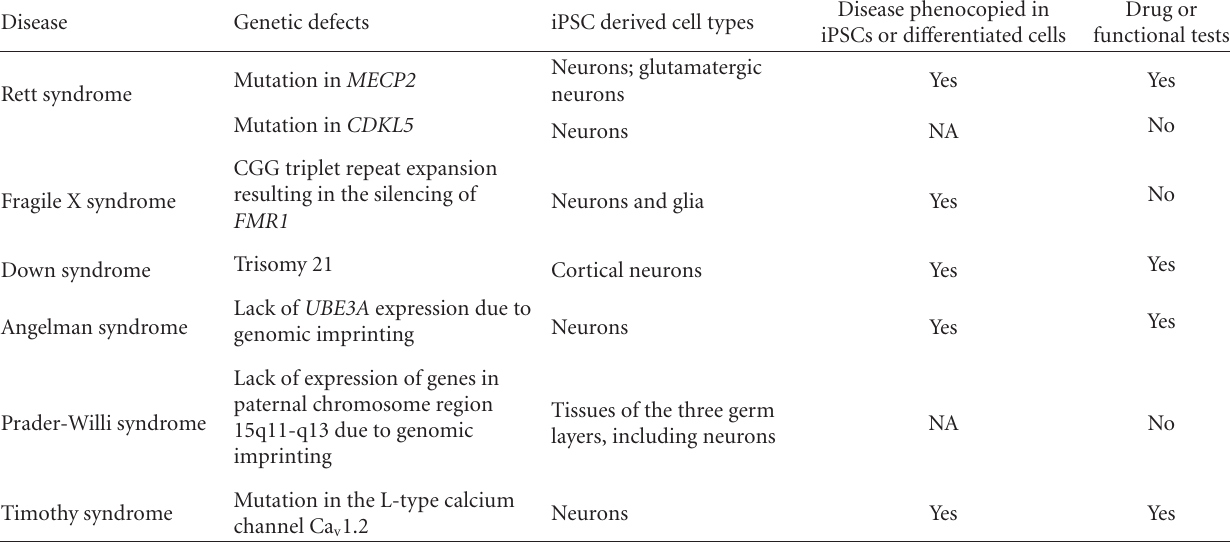
Table 1: Genetic neurodevelopmental disorders modeled with iPSCs.